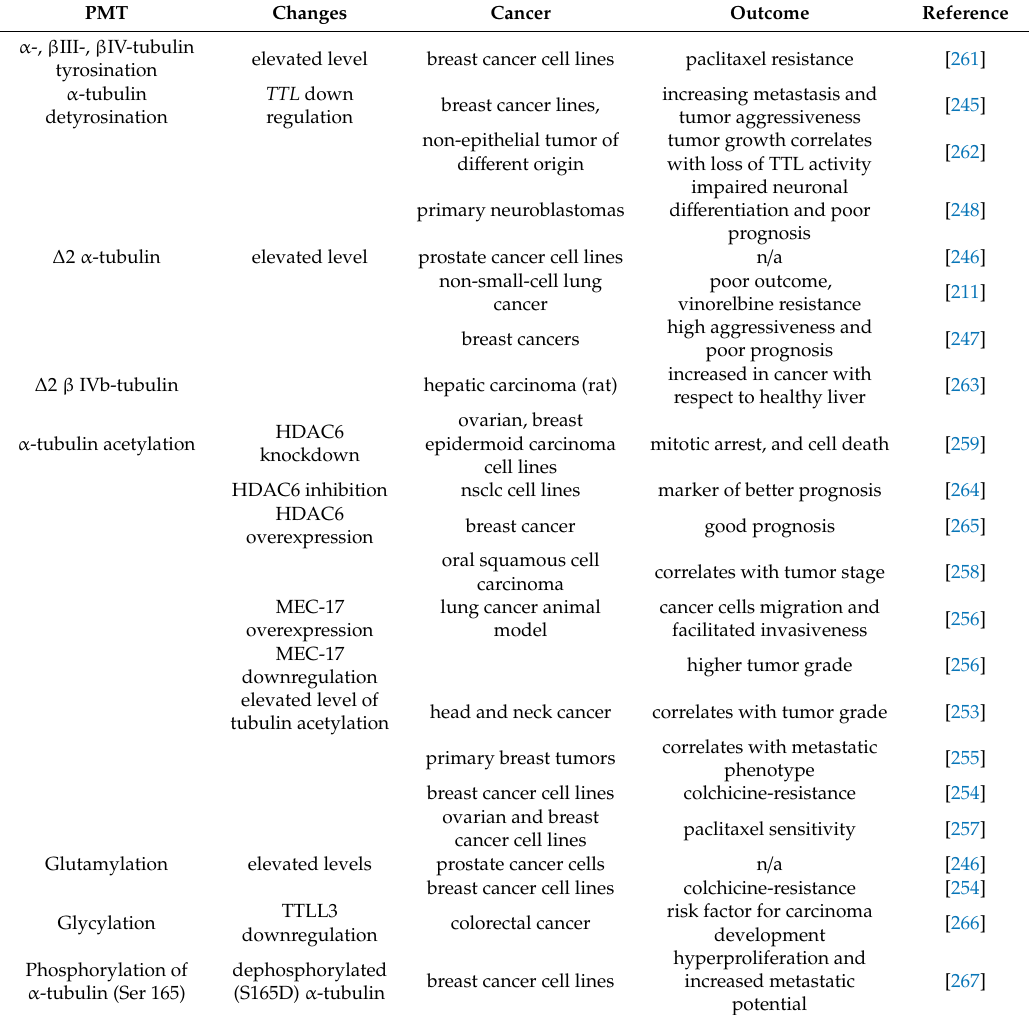
Table 3. Alterations in tubulin post-translational modifications (PTMs) in